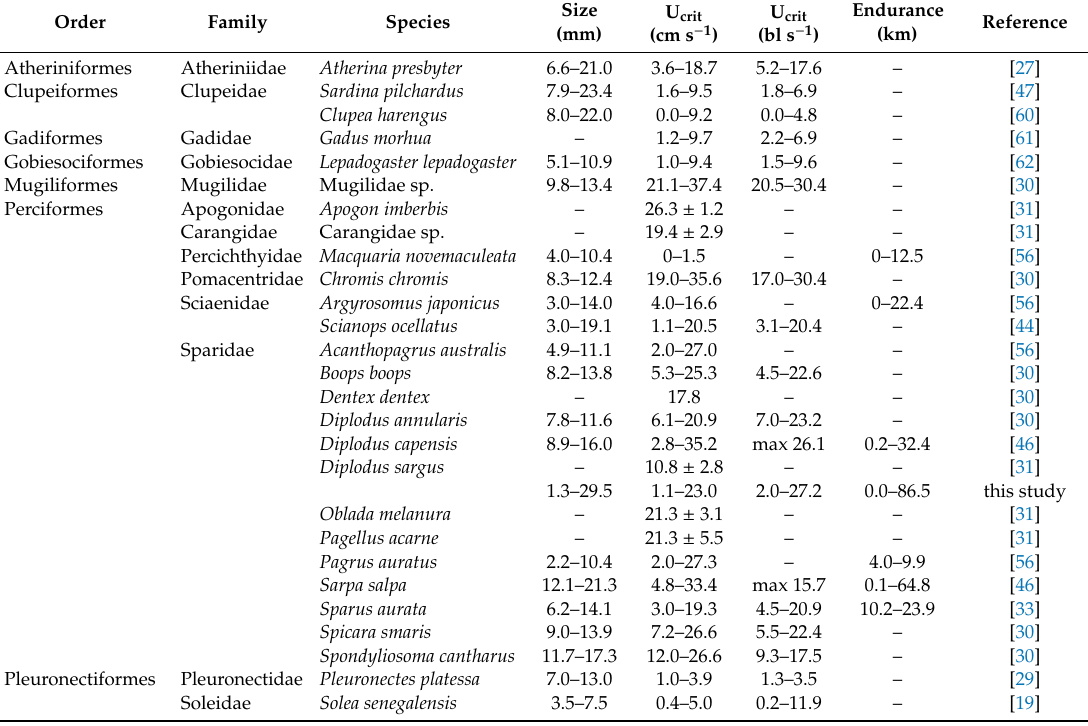
Table 3. Summary of reports on swimming performance (critical swimming speed—Ucrit;swimming endurance—km) of larvae of several temperate fish species. The size range of larvae tested is also shown. Order